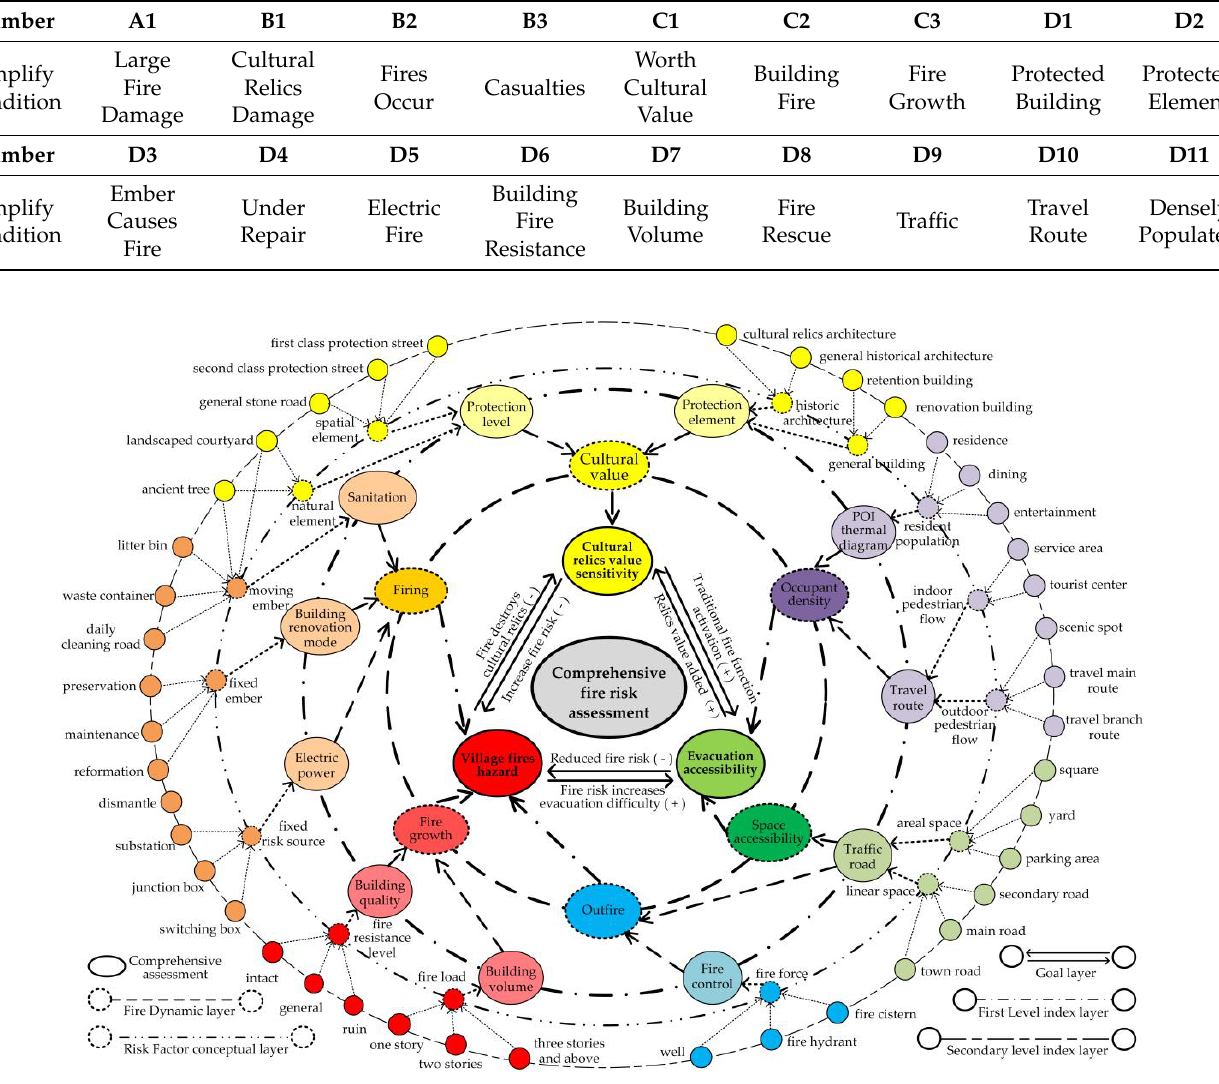
Table 3. Netica index simplification form.